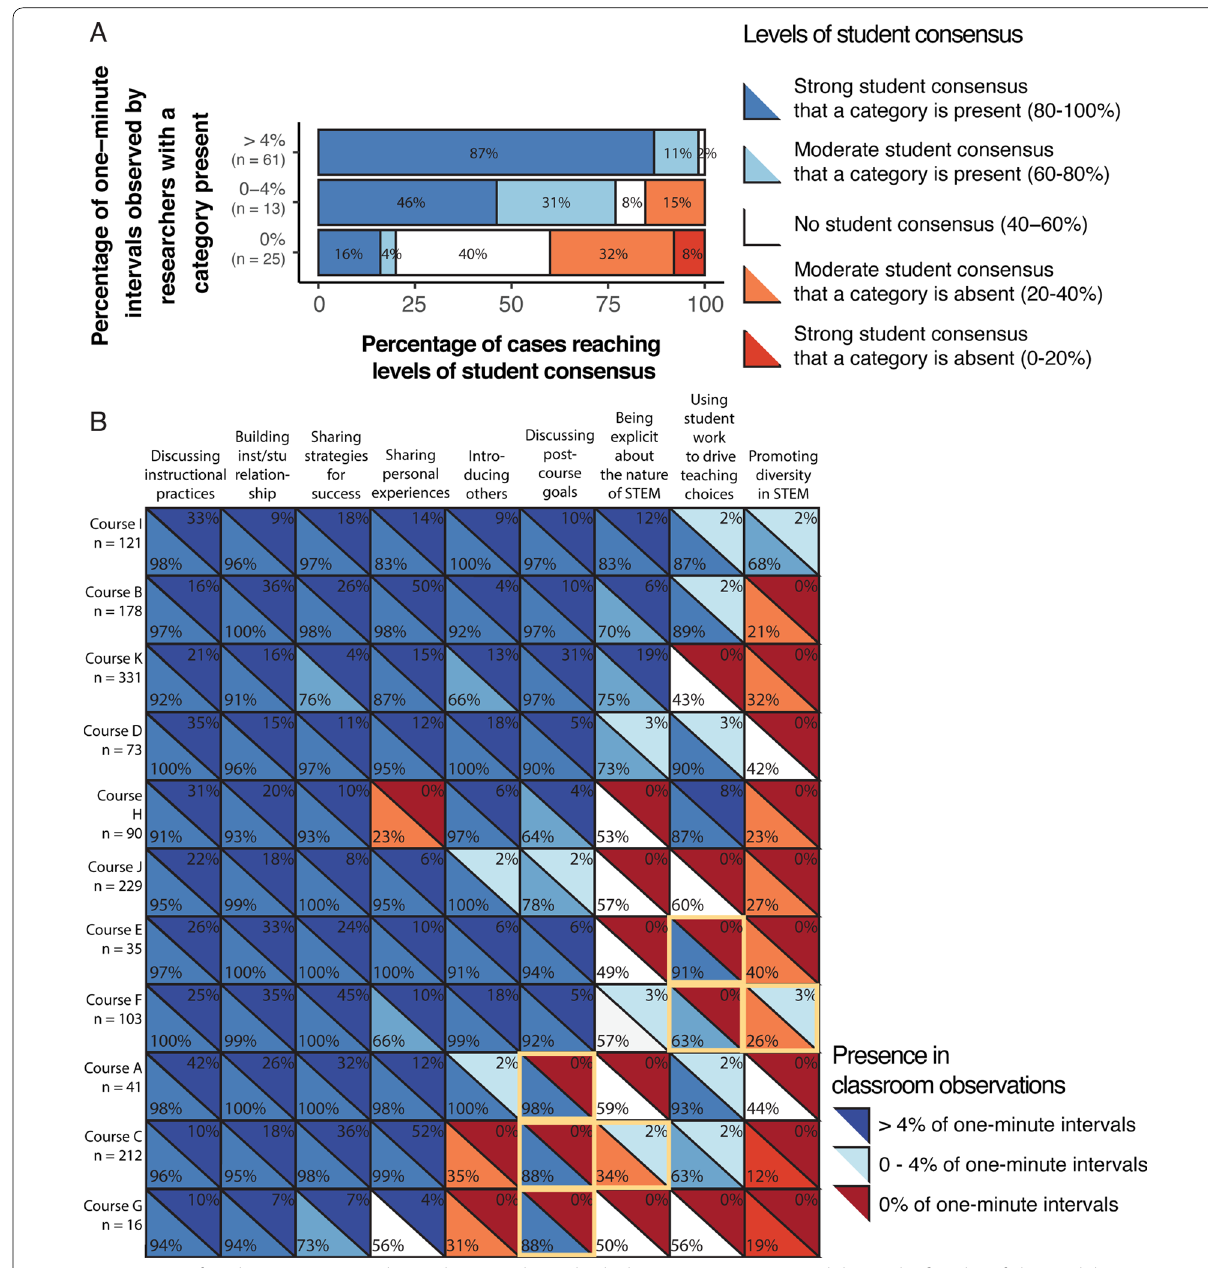
Fig. 2 Comparison of student consensus within each course that individual categories were covered during the first day of class and the percentage of 1 min intervals observed by researchers. A Each stacked bar represents the total percentage of categories from across all 11 courses where researchers observed at least 4%, 0–4%, or 0% of 1 min intervals dedicated to a category. Within each stacked bar, the colors represent the percentage of cases where students from a course reached varying levels of consensus that a category was present or absent. B Detailed summary of the cases depicted in ( A ). The upper right triangles depict the percentages of 1 min intervals observed by researchers for each course, shaded according to the bins shown in the key to the right. The lower left triangles depict levels of student consensus that a category was present or absent, shaded according to the levels shown in the key above. Courses are ordered from top to bottom according to the number of categories with strong student consensus that a category was present, and the number of researcher observations of high frequency (at least 4% of 1 min intervals). The number of student responses from each course is included below each course number. Yellow borders indicate noteworthy cases of observer–student